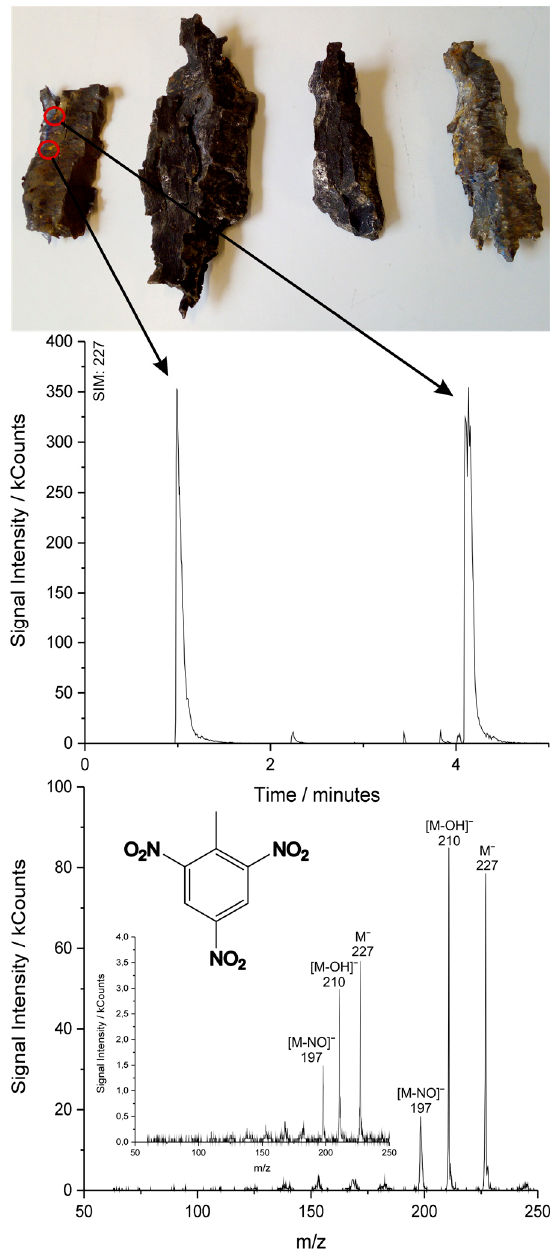
Figure 3. Desorption in negative CI mode of TNT from the surface of shrapnel recovered from a defused bomb of the Second World War. All shrapnel in the upper image show clear signals of TNT when investigated. A part of one of those single ion traces can be seen in the mass profile where the TNT signal at m / z 227 is plotted. The full size mass spectrum shows the first peak at about 1 min. The panel in the lower left shows the spectrum of a 10 ng TNT standard sample, measured under the same conditions. The signals look similar for every detected TNT trace and shrapnel.